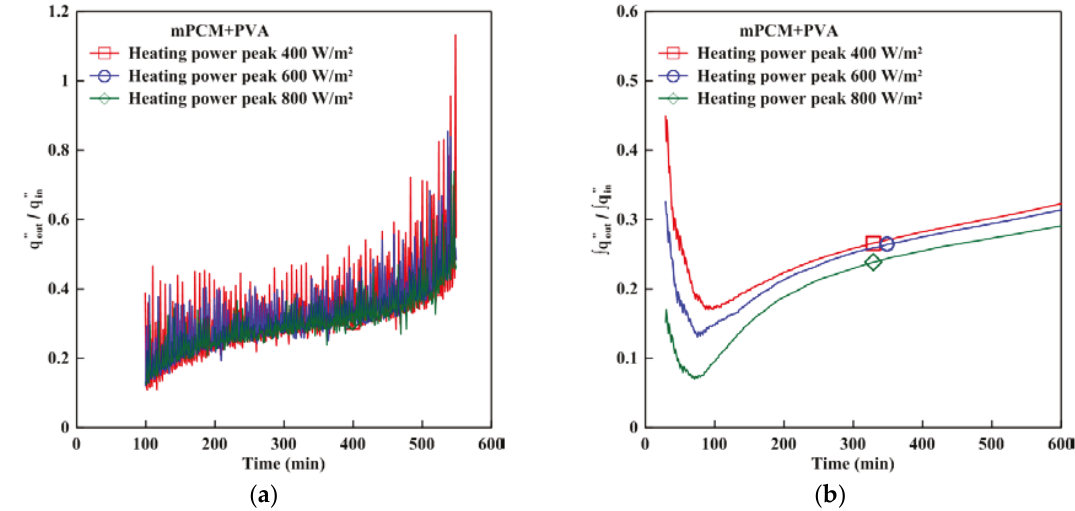
Figure 10. Histories of ( a ) instantaneous and ( b ) time-averaged, fractional heat penetration onto the interior side of the macroPCM + PVA wall tile with various heating powers.